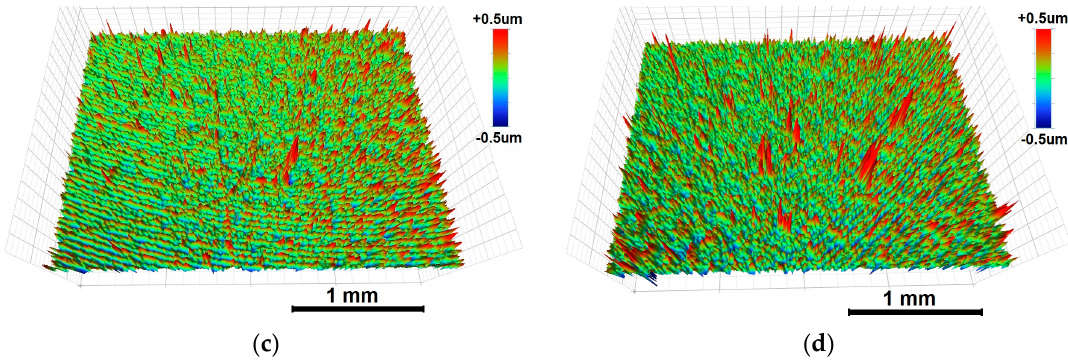
Figure 12. Representative ( a , b ) 2D height profiles and ( c , d ) 3D surface topography images of the MRE sheet containing CI- g -PHEMAMTS-1 particles at ( left ) the off-state and ( right ) in the presence of the external magnetic field.